Question: Write a single sentence explaining what this figure depicts.
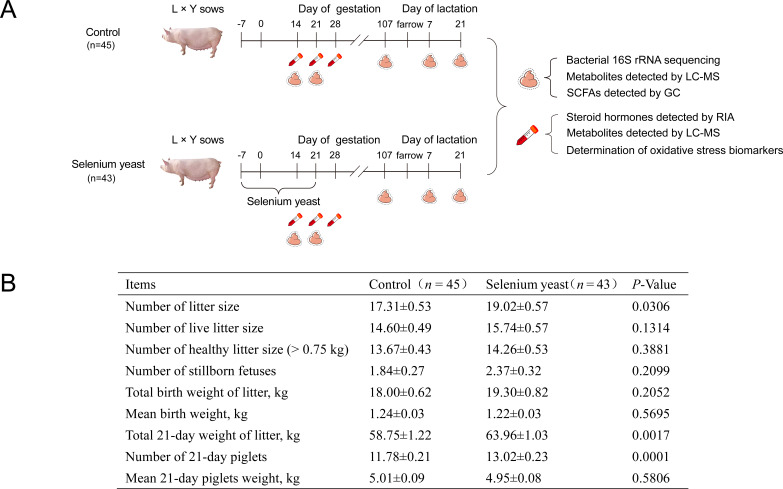
Answer: Overview of the experimental design and the comparative analysis of reproductive performance between two groups. ( A ) Overview of the experimental design. The control group included 45 sows, and the selenium yeast group included 43 sows. ( B ) Analysis of differences in reproductive performance between control and selenium yeast groups. Statistical significance between groups was determined by unpaired Student’s t -test. All data were presented as mean ± standard error of the mean (SEM). P values < 0.05 were considered statistically significant.